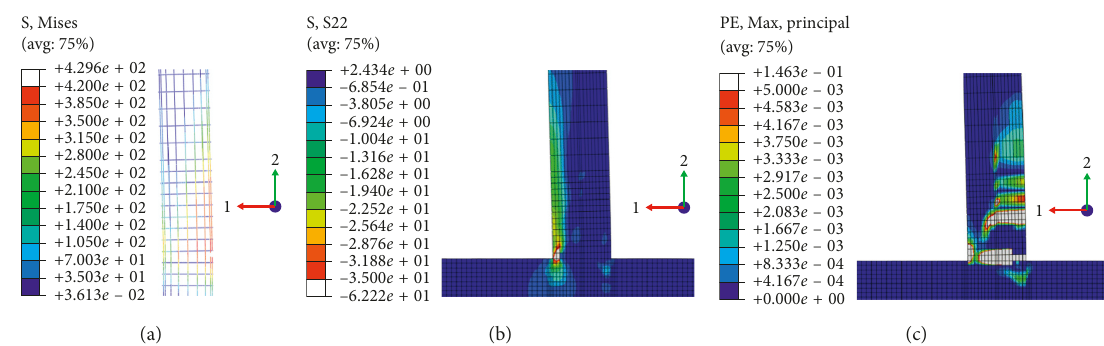
Figure 18: F-SD400 at the final stage (4.46%): (a) reinforcement stress distributions; (b) concrete stress distributions; and (c) concrete cracks.